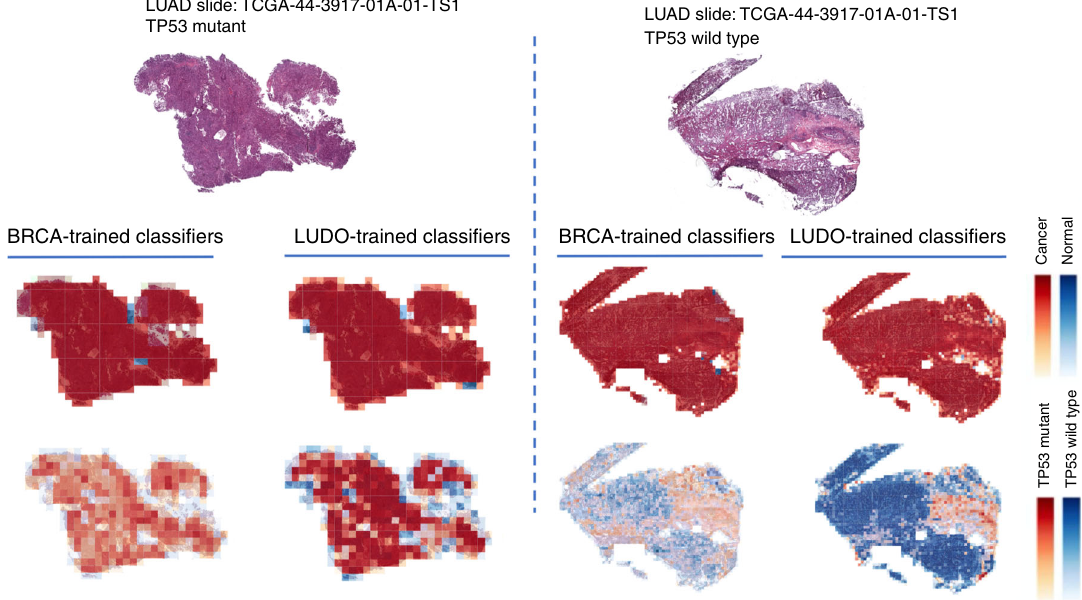
Fig. 8 TP53 genotype heatmaps based on predicted probabilities using our deep learning model. The fi rst row shows two LUAD H&E slides with TP53 mutant (left panel) and wild type (right panel). The second row shows prediction maps for these two slides using tumor/normal classi fi ers trained on BRCA and LUAD samples. Both models successfully classify samples as cancer and predict similar heatmaps. The third row shows prediction maps for these slides using TP53 mutation classi fi ers trained on BRCA and LUAD. The BRCA-trained and LUAD-trained heatmaps are similar, suggesting that there are spatial features for TP53 mutation that are robust across tumor types.